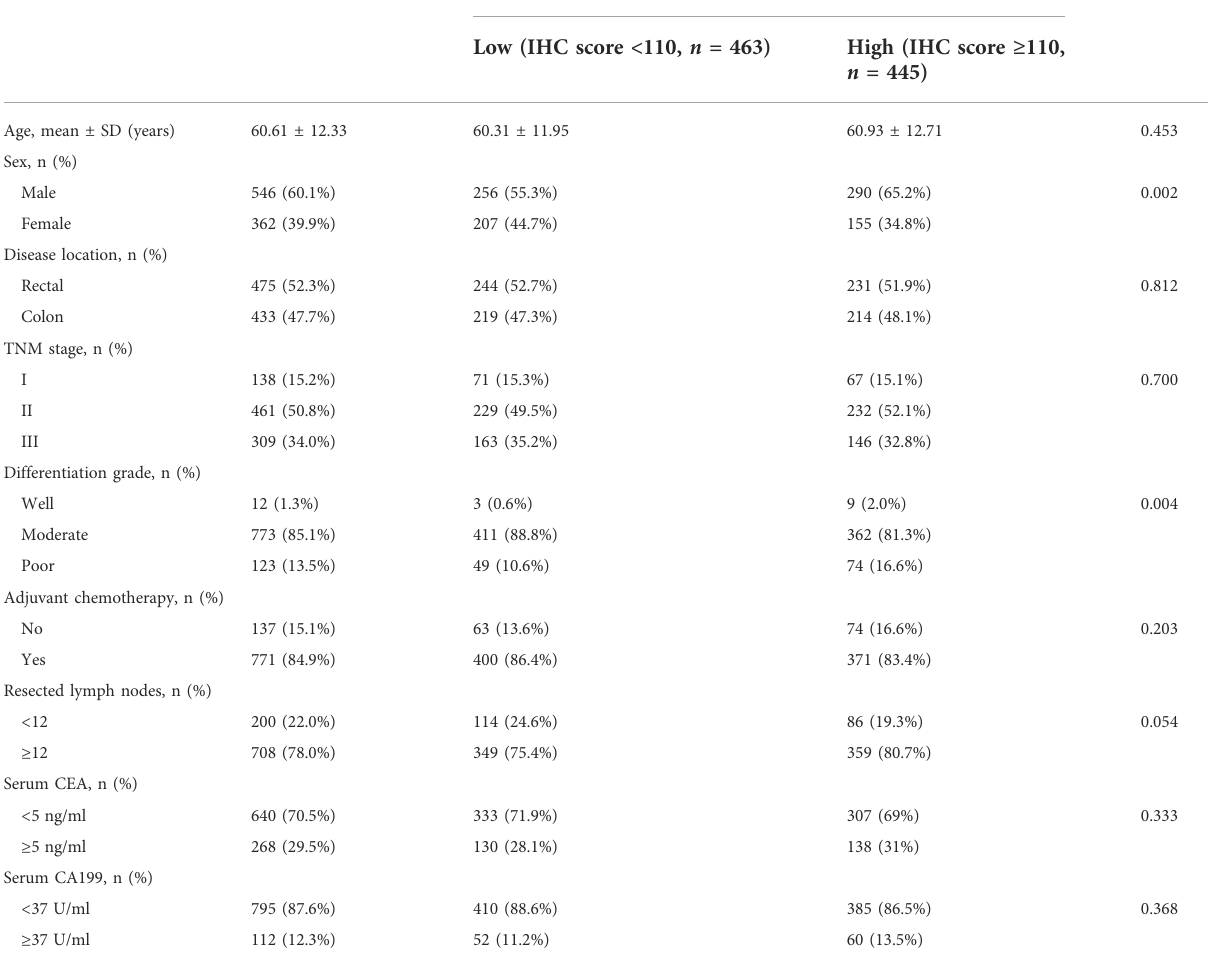
TABLE 1 Characteristics of patients with